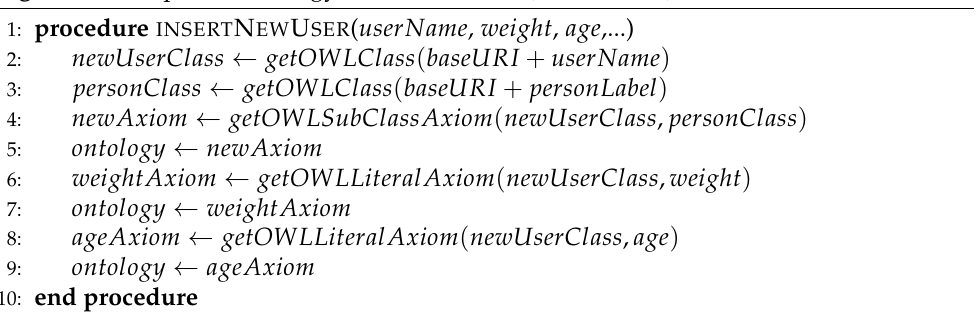
Algorithm 2 Populate ontology with a new user (class Person